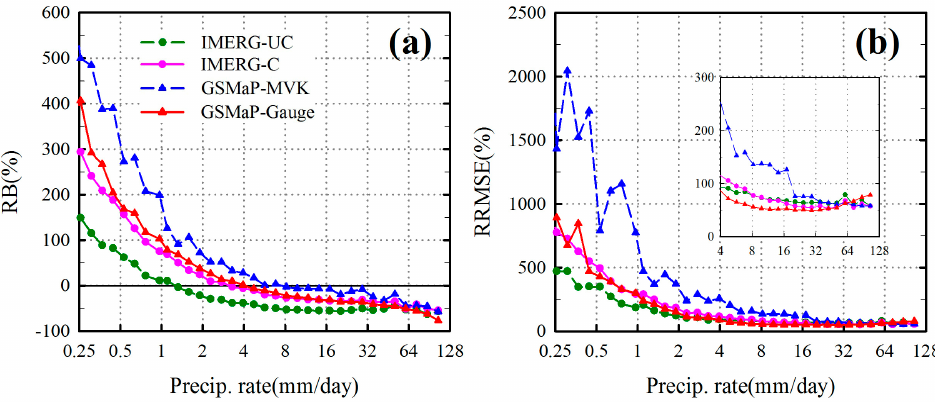
Figure 8. The relationship between the validation indices and precipitation rate: ( a ) RB, and ( b ) RRMSE.